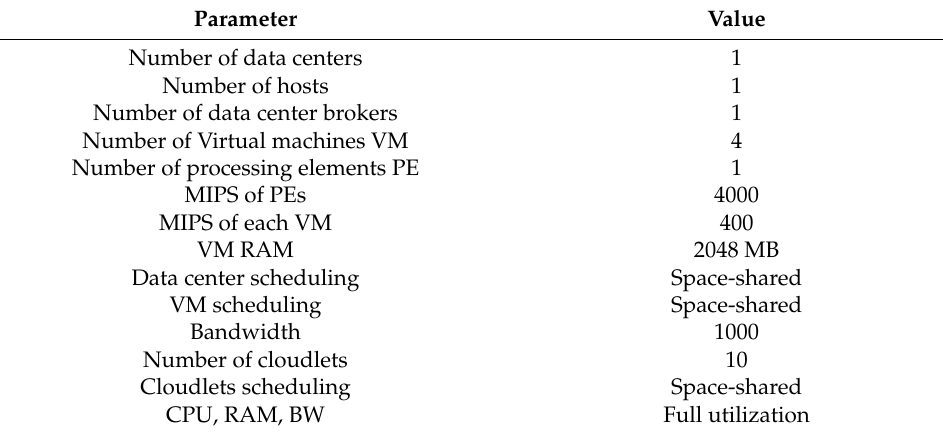
Table 2. CloudSim simulation parameters.